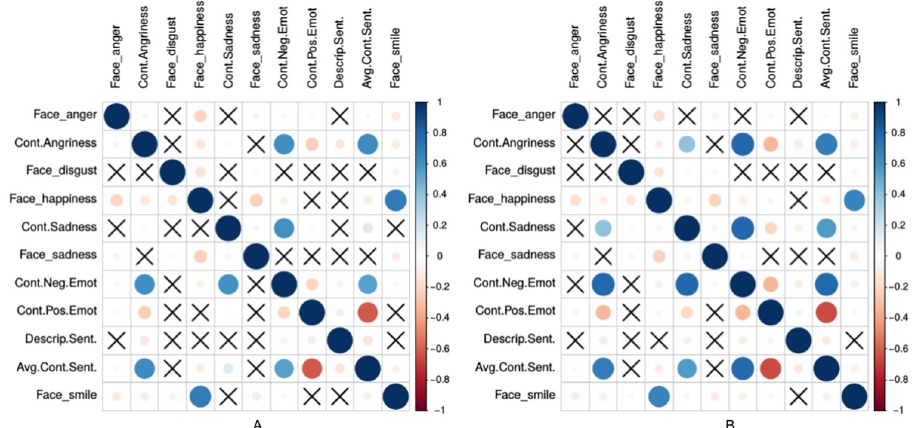
Fig 3. The Pearson correlation between the average emotions derived from facial expressions through the shared images and emotions from textual content for depressed -(a) and control users -(b). Pairs without statistically significant correlation are crossed (p-value <